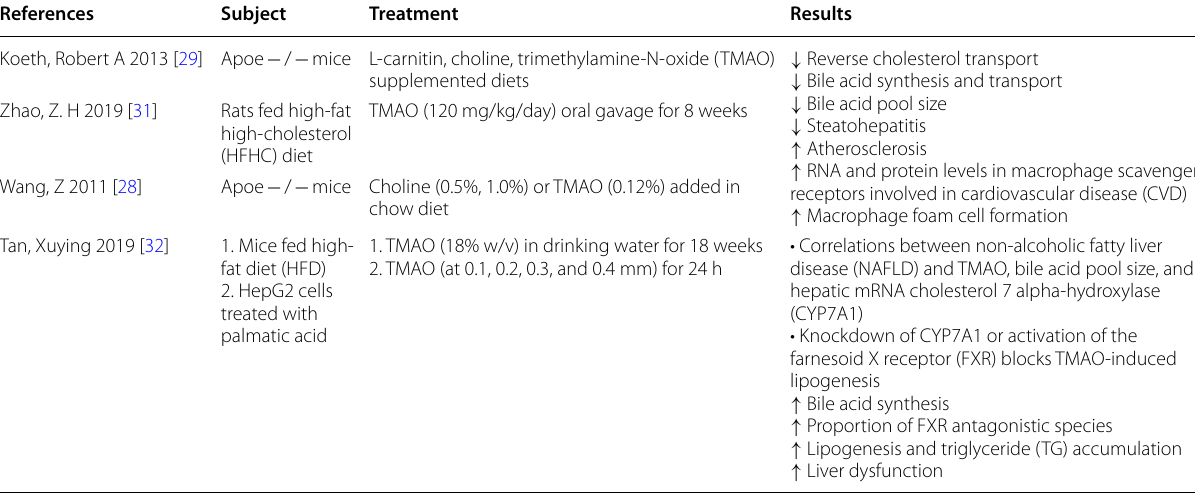
Table 1 Effects of trimethylamine-N-oxide on different states of cholesterol